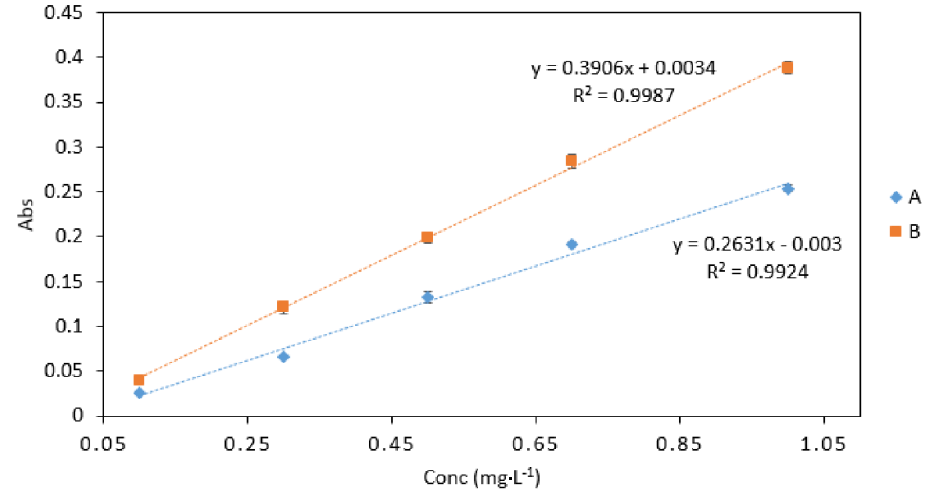
Figure 5. A comparison of Cr VI (0.1–1 mg · L − 1 ) analysed using two sample / reagent ratios: ( A ), 2 (Cr): 2 (0.4 M sulphuric acid): 2 (DPC) and ( B ), 2 (Cr): 2 (0.4 M sulphuric acid and DPC mix). All